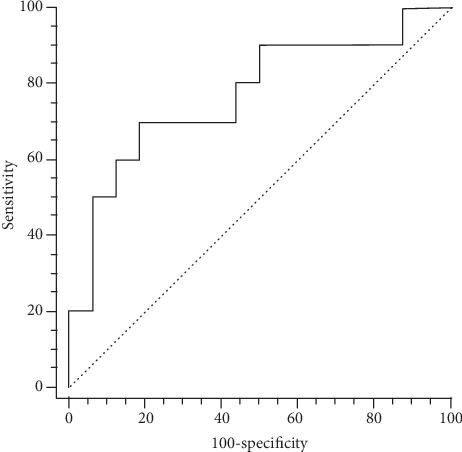
The ROC curvature of the SN2 based on the SUVmax in patients with squamous carcinoma.